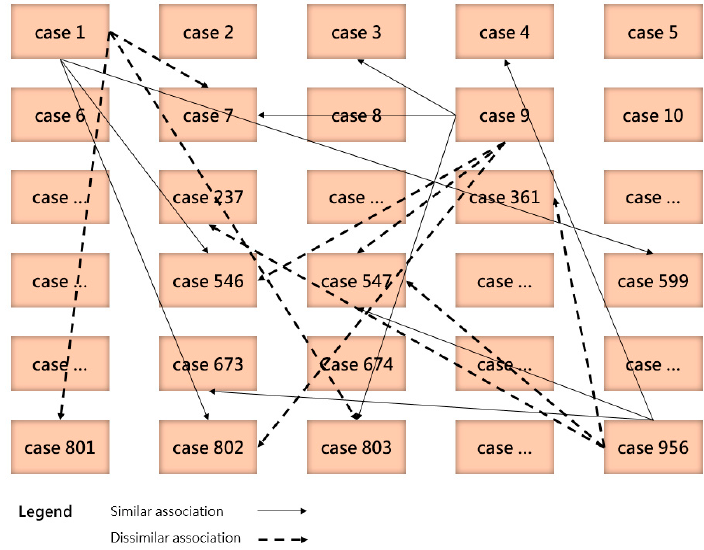
Figure 9. The similar and dissimilar association relations between cases.